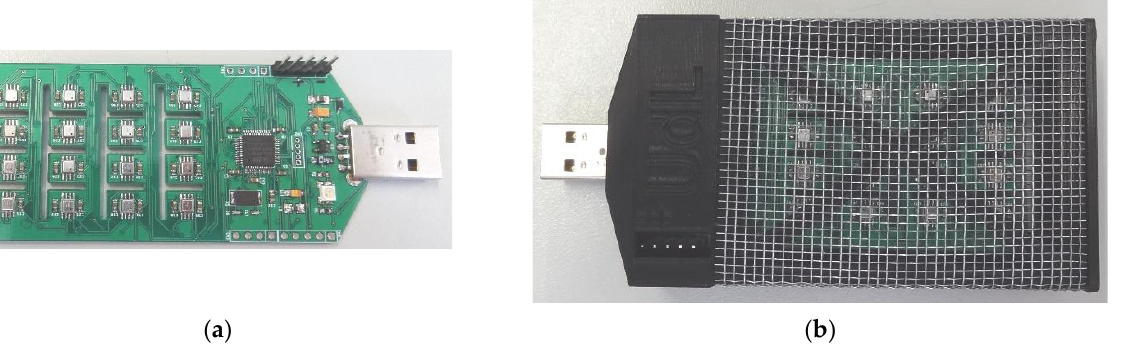
Figure 1. Images of the compact Osmee One eNose used in this paper: ( a ) detail of the electronic board showing the array of sensing devices; ( b ) detail of the case of the eNose using a steel mesh to facilitate air circulation.